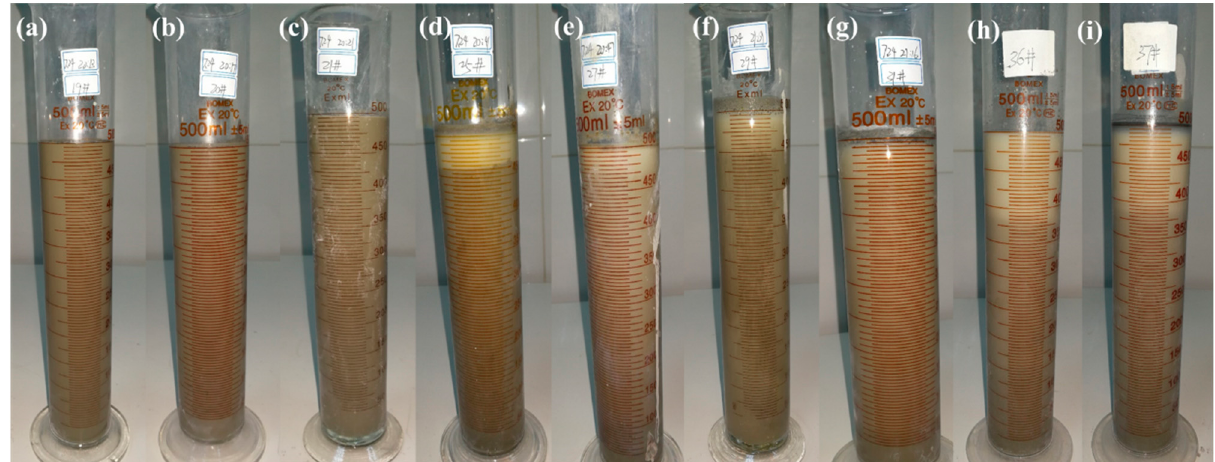
Figure 9. Typical bleeding photos of the fresh slurries ( a ) CEMIII/B, 1.0, 0.6%M ( b ) CEMIII/B, 1.0, 1.2%M ( c ) CEMIII/B, 1.0, 1.8%M ( d ) CEMIII/B, 1.5, 2.0%N ( e ) CEMIII/B, 1.5, 2.5%N ( f ) CEMIII/B, 1.5, 1.2%PCE ( g ) CEMIII/B, 1.5, 1.5%PCE ( h ) CEMIII/B, 1.5, 1.5%M ( i ) CEMIII/B, 1.5, 1.8%M.